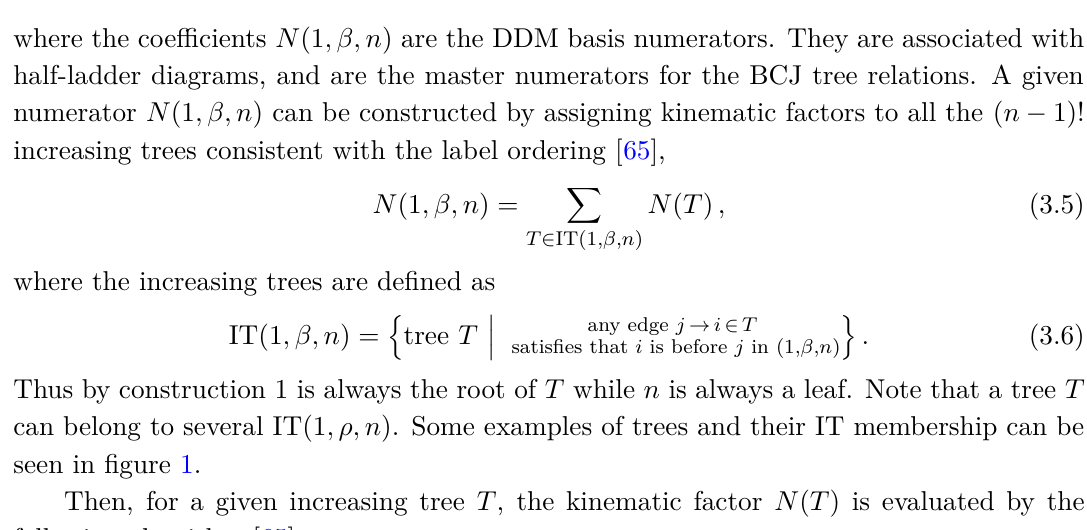
Algorithm 1 (Reference Order Evaluation). Construction of the kinematic factor for a spanning tree T , using a given reference ordering R ∈ S